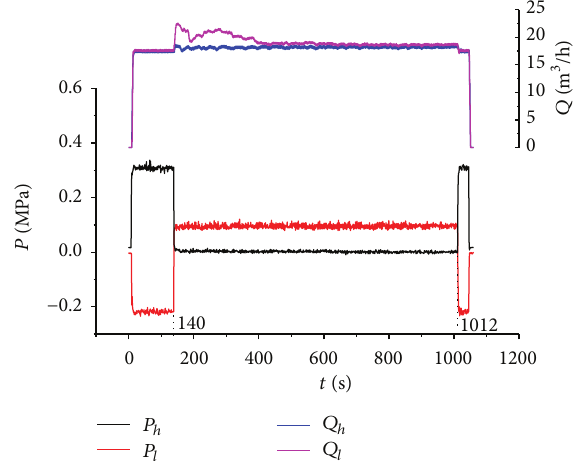
Figure 6: Variation trend of flow and differential pressure in experiment I. 𝑃 ℎ —differential pressure of sliding vane pump, 𝑃 𝑙 — differential pressure of centrifugal pump, 𝑄 ℎ —outlet flow of sliding vane pump, and 𝑄 𝑙 —outlet flow of centrifugal